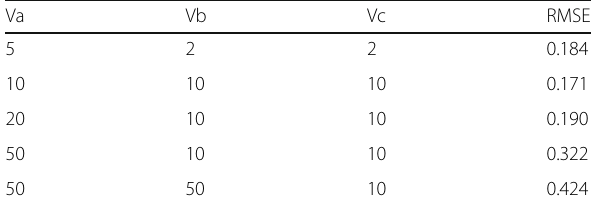
Table 6 Prediction deviation of single-node multi-feature model